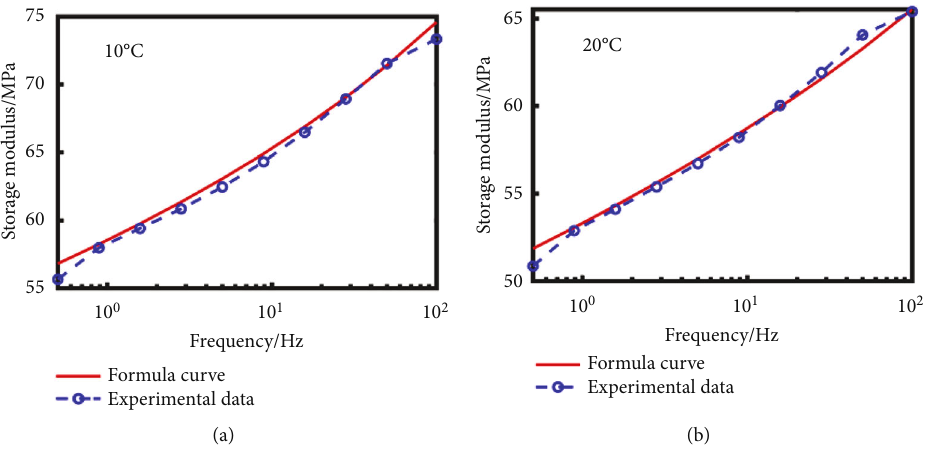
Figure 5: (a) The comparison between the formula curve of energy storage modulus at 10 ° C and the test data shows that R -square=0.9912. (b) The comparison between the formula curve of energy storage modulus at 20 ° C and the test data shows that R